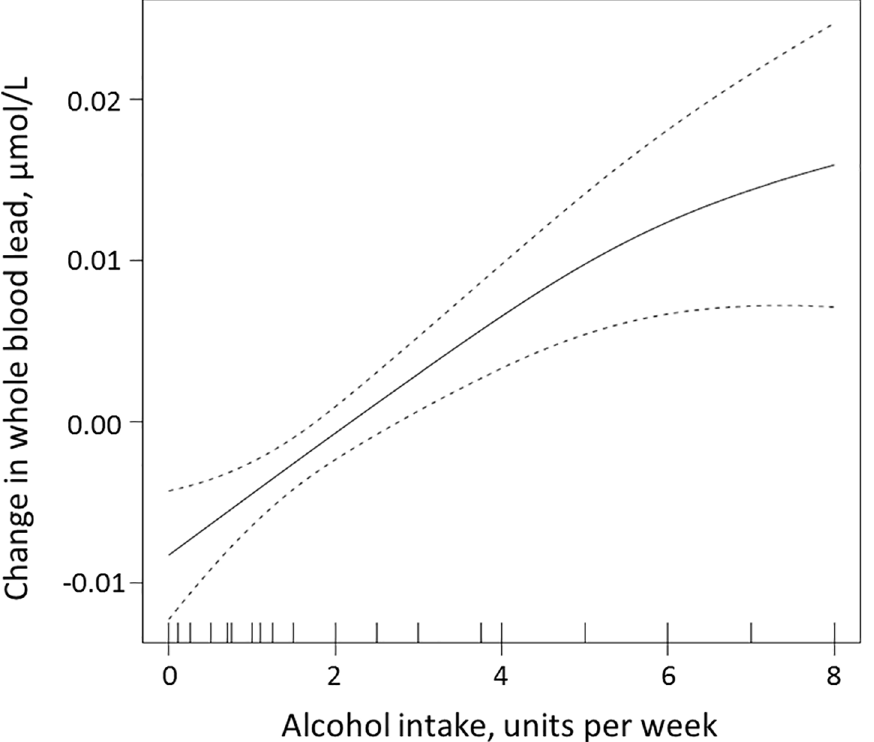
Fig 1. The association of alcohol intake in units per week with Pb levels by generalized additive model (GAM), adjusted for age. The solid line shows the fitted model and the area betweenthe dotted lines indicate